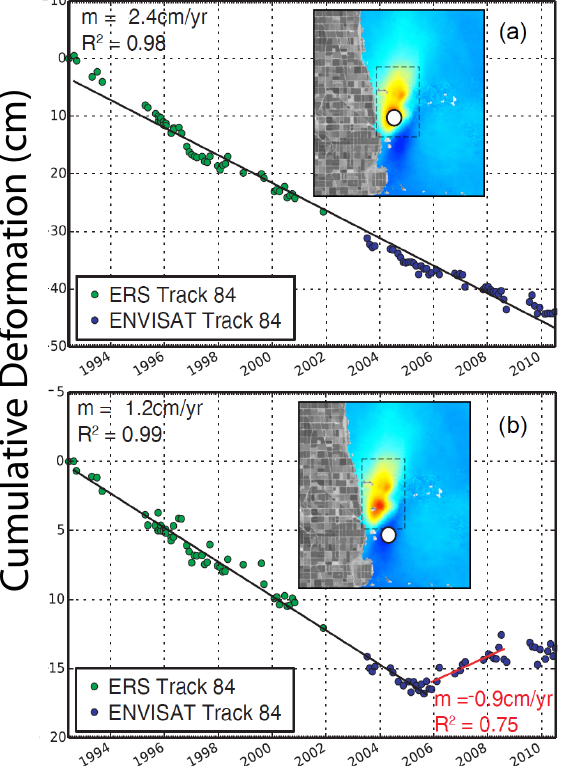
Figure 8. Cumulative LOS displacement showing maximum subsidence ( a ) and uplift ( b ) at East Mesa for the combined ERS and Envisat track 84 time series taken from the two locations shown by the white circles in the respective inset maps (see Figure 7b for scale). We assumed the deformation rate was constant during the interval between ERS and